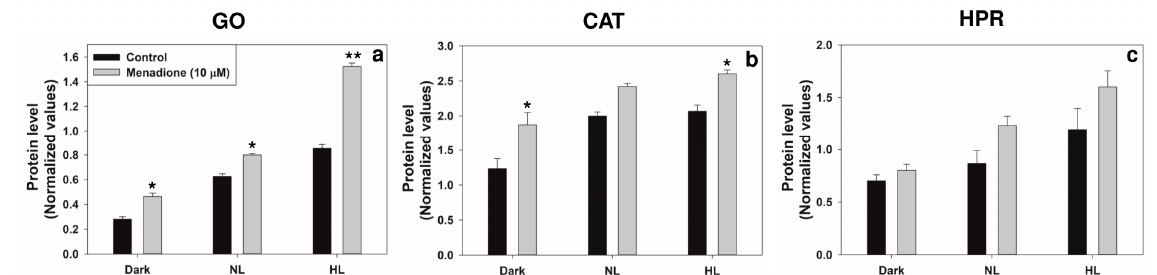
Figure 5. The transcript levels of glycolate oxidase (GO) ( a ), catalase (CAT) ( b ), hydroxypyruvate reductase (HPR) ( c ), glycerate kinase (GK), ( d ), and phosphoglycolate phosphatase (PGLP) ( e ), in extracts from leaf discs on exposure to MD and/or high light (HL, 1200 µmol m − 2 s − 1 ). The expression of genes was represented as fold-change after normalization with actin 2. Each data point is the average of three replicates, and error bars represent ±SE. Asterisks indicate the signifi- cance of MD effect compared to the respective control. * p < 0.05 ; ** p < 0.001.